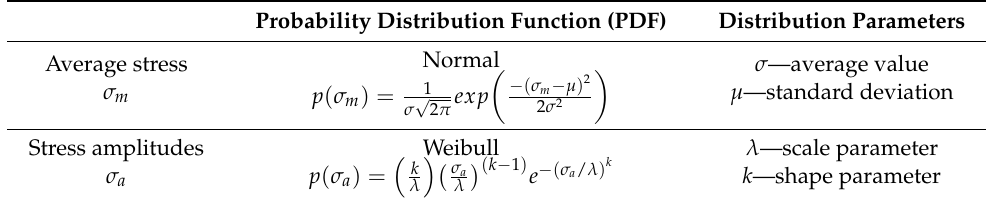
Figure 18. Calculation scheme of the fatigue parameter D , based on the fatigue surfaces [18,21,22]. Description of markings in the text. Table 12. Applied, exemplary types of probability distribution function of the analysed